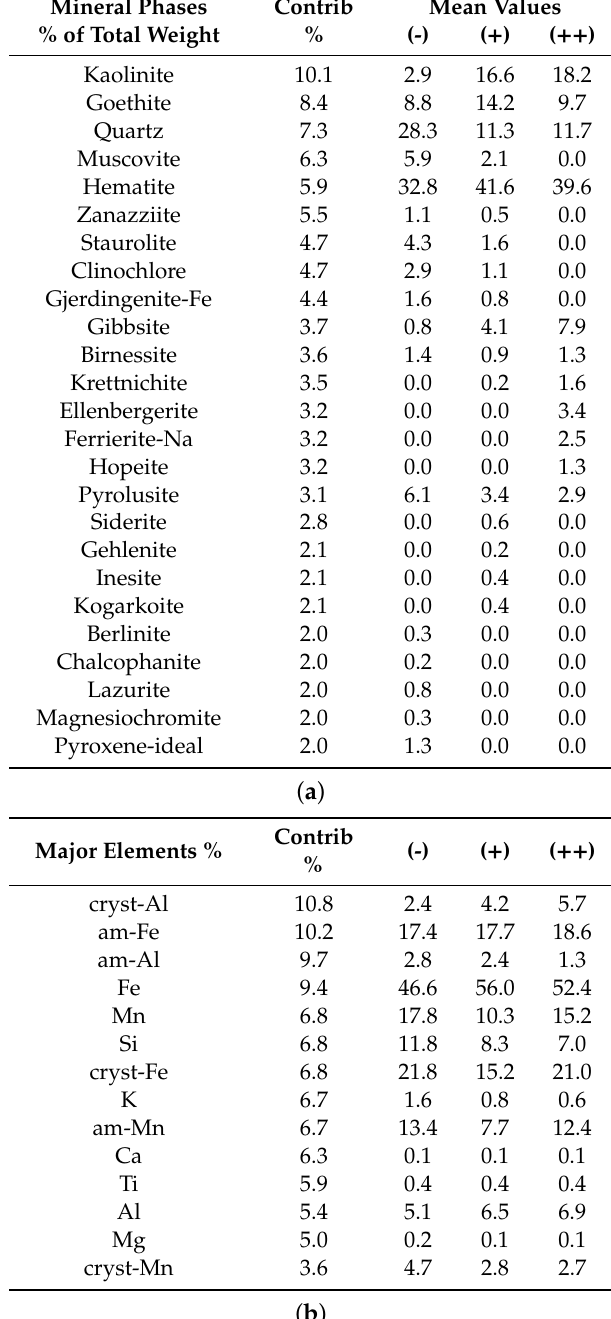
Table 2. Outputs of the similarity percentage analysis (SIMPER) test performed on normalized data on the three sample groups with di ff erent As adsorption potential, classified as “not suitable (-)”, “suitable ( + )”, and “promising ( ++ )”. The mineralogical phases ( a ), major ( b ) and trace ( c ) elements were tested separately. The parameters were sorted in descending order of percentage contribution (Contrib %) to the observed di ff erence between sample groups. Mean values for each variable and sample group are also